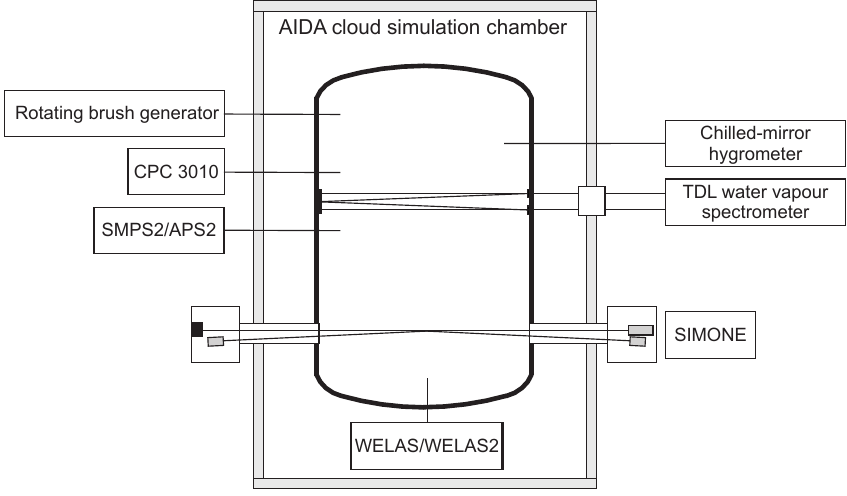
Fig. 1. Schematic drawing of the AIDA cloud chamber: aerosol instrumentation (rotating brush generator, APS, SMPS, CPC3010) and in- struments used for characterisation of the droplet/ice crystal population (WELAS/WELAS2, SIMONE) and relative humidity measurements (TDL, chilled-mirror